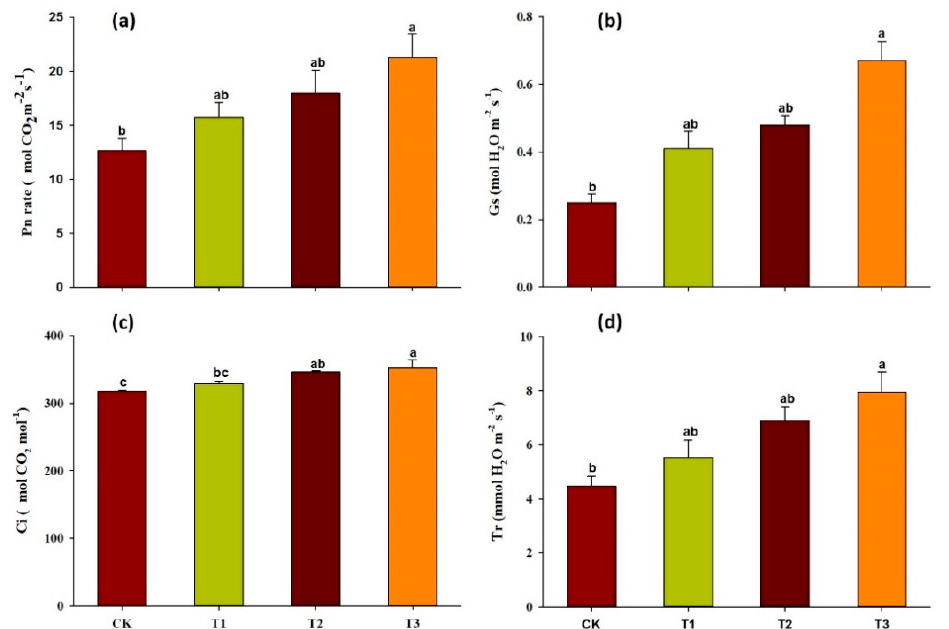
Figure 2. Photosynthetic gas exchange parameter analysis. Net photosynthetic assimilation (Pn) ( a ); stomatal conductance (Gs) ( b ); intercellular CO2 concentration (Ci) ( c ); and transpiration rate (Tr) ( d ) in fully expanded cucumber leaves in response to garlic substrate addition. Data are the mean ± SD from three replicates.